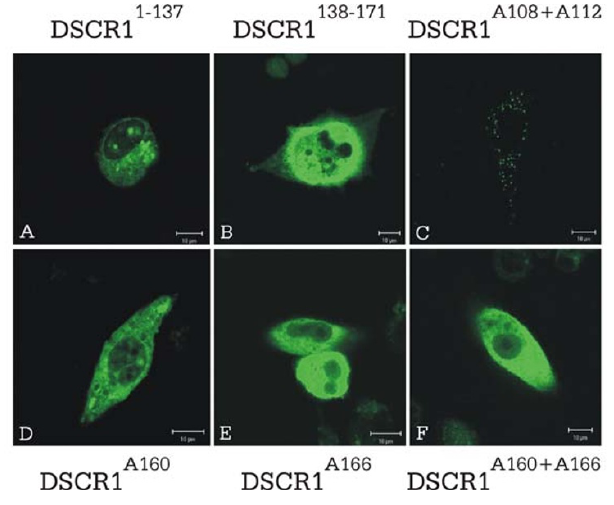
Figure 4 Confocal laser scanning microscope images of DSCR1-mutated forms after the addition of PMA/ Ionomycin and/or Cyclosporin A. Subcellular location of: DSCR1 1–137 (A), DSCR1 138–171 (B), DSCR1 A108+A112 (C), DSCR1 A160 (D), DSCR1 A166 (E) and DSCR1 A160+A166 (F). Treatments with PMA/Ionomycin and Cyclosporin A did not influence the subcellular location patterns. Scale bars are indicated in the